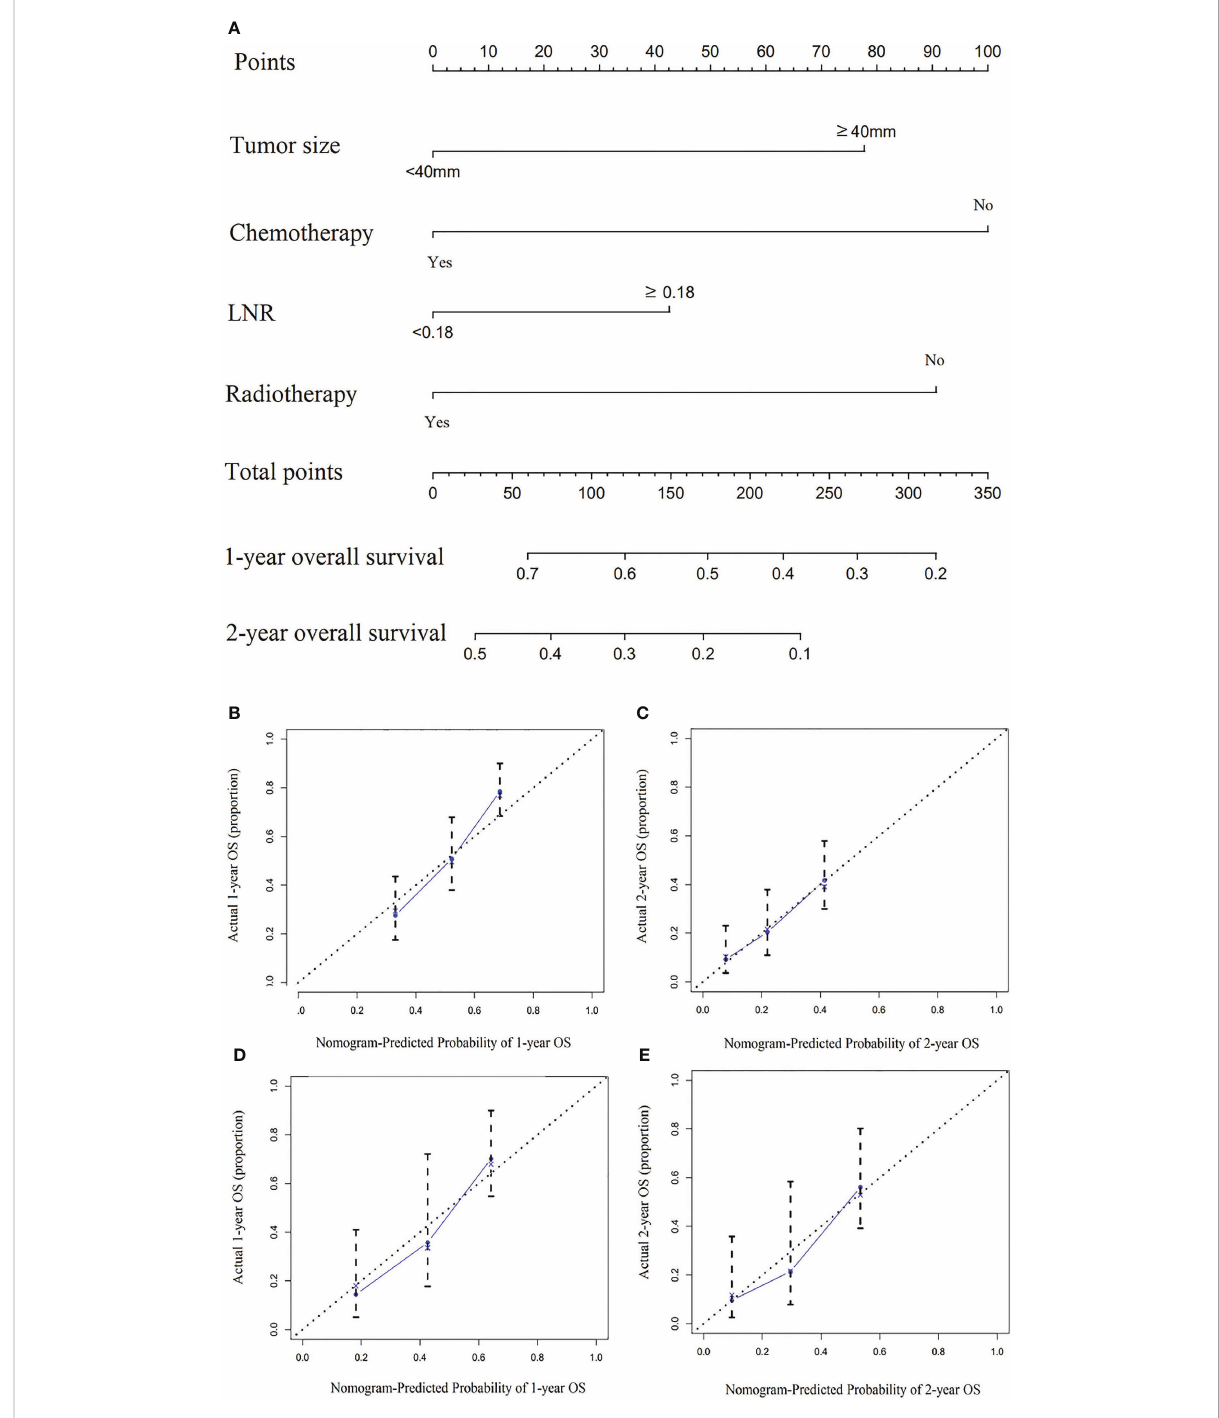
FIGURE 1 (A) The nomogram for predicting the overall survival of patients with pancreatic adenosquamous carcinoma. (B – E) The 1-year and 2-year calibration curves of the development group and the internal veri fi cation group for prognostic nomogram of patients with pancreatic adenosquamous carcinoma (B) 1-year development group (C) 2-year development group (D) 1-year internal veri fi cation group (E) 2-year internal veri fi cation